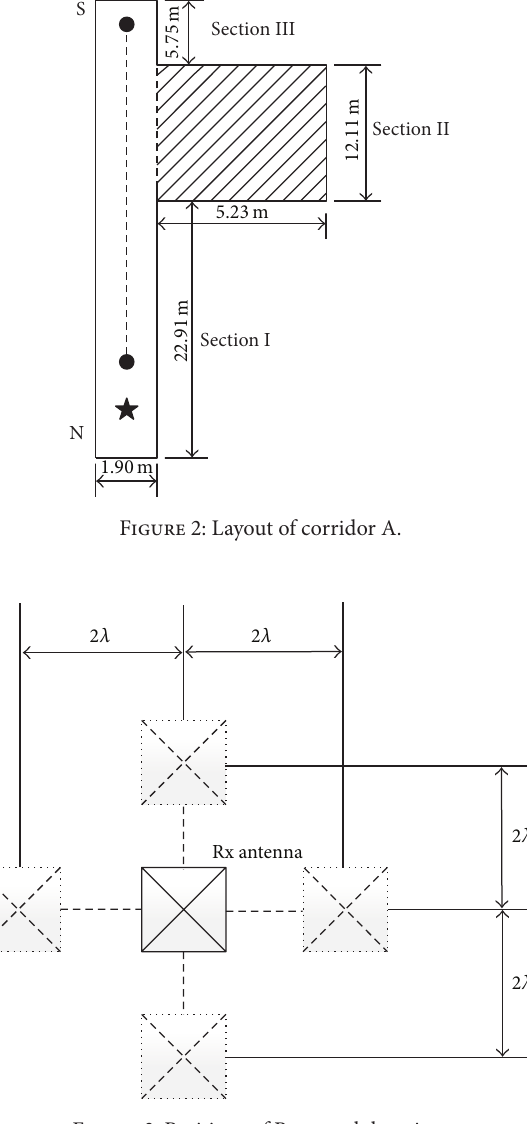
Figure 3: Positions of Rx at each location.